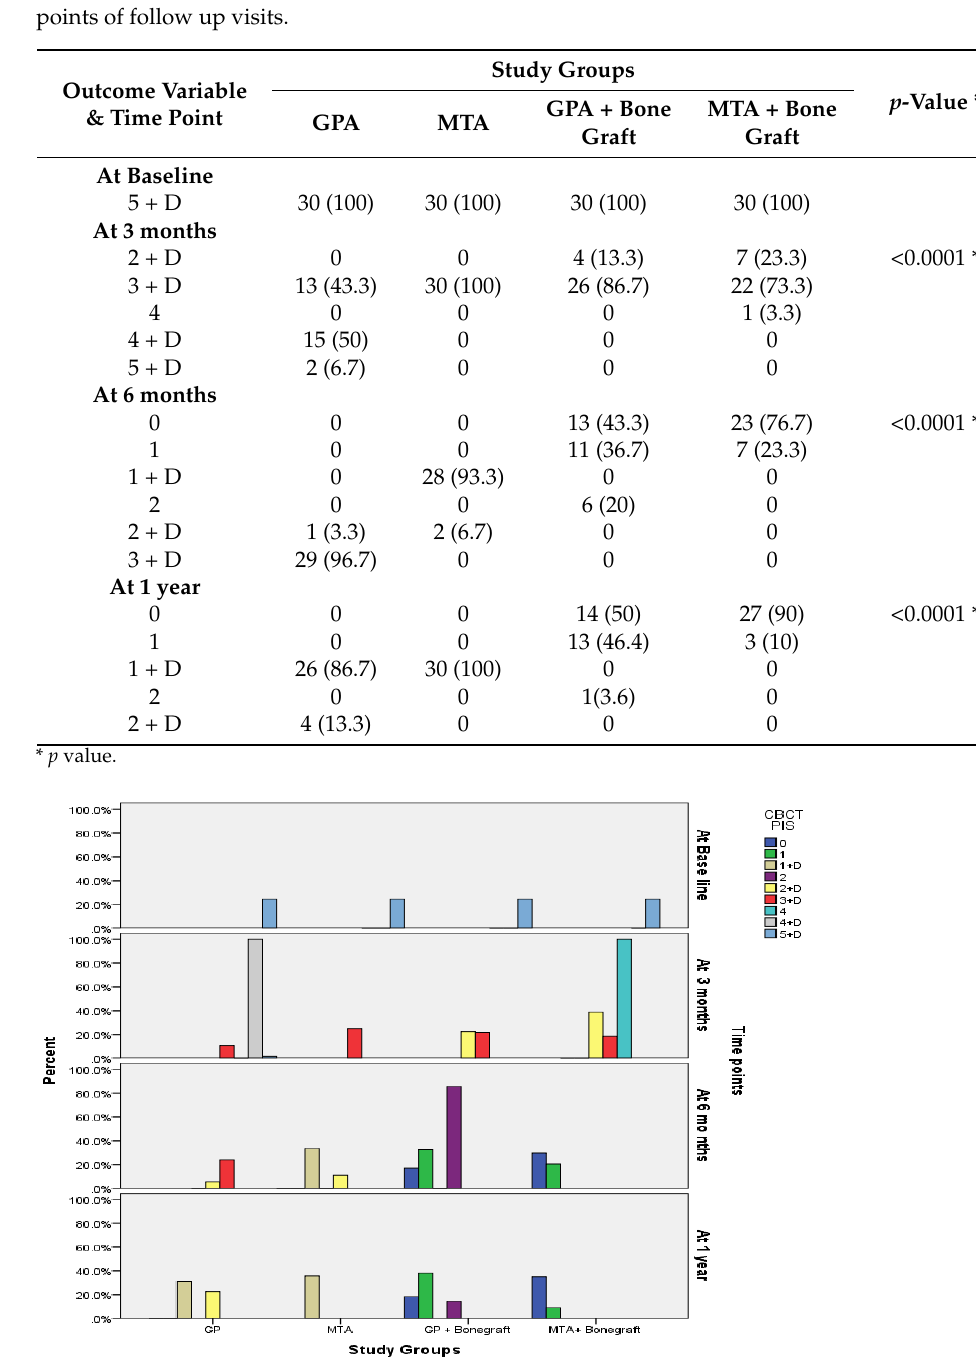
Figure 1. Display of changes in CBCTPAI among the four study groups at each of the four time points of follow up visits.